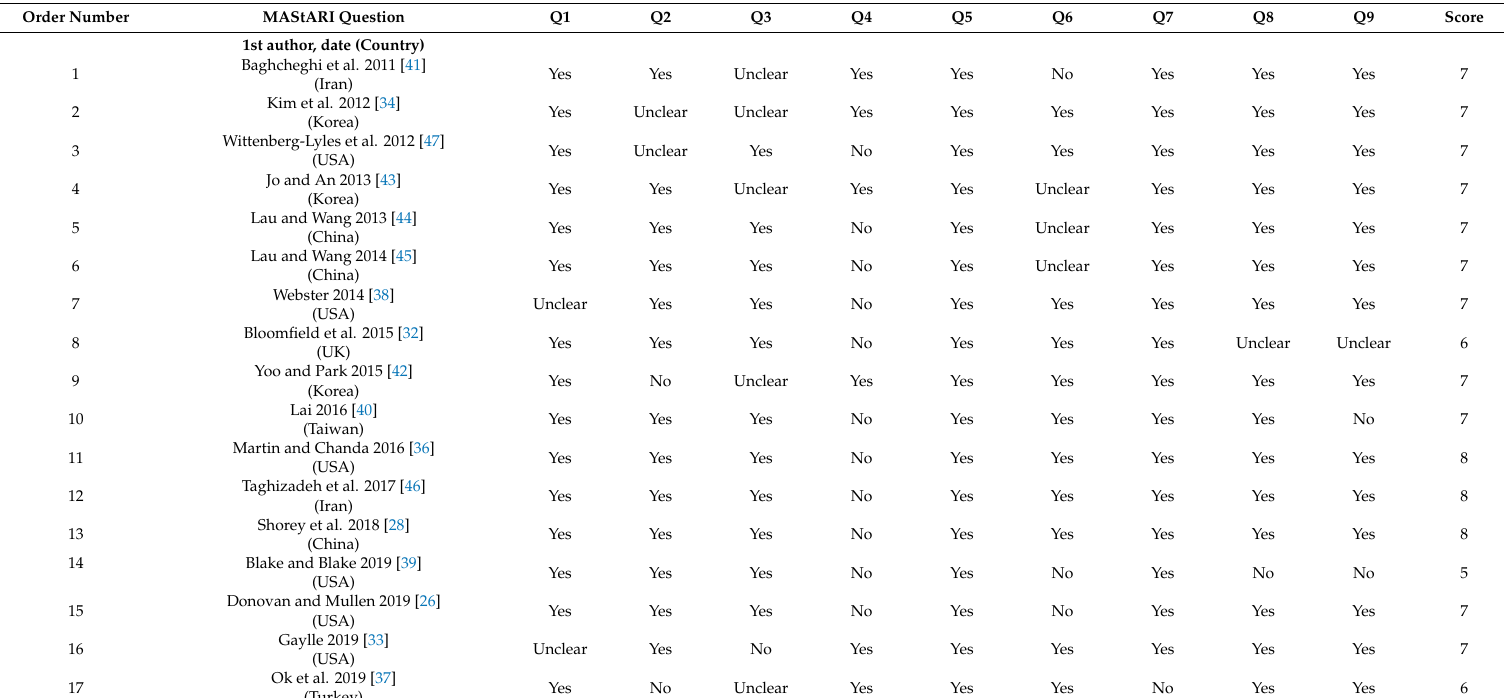
Table 4. Results of critical appraisal for quasi-experimental studies.